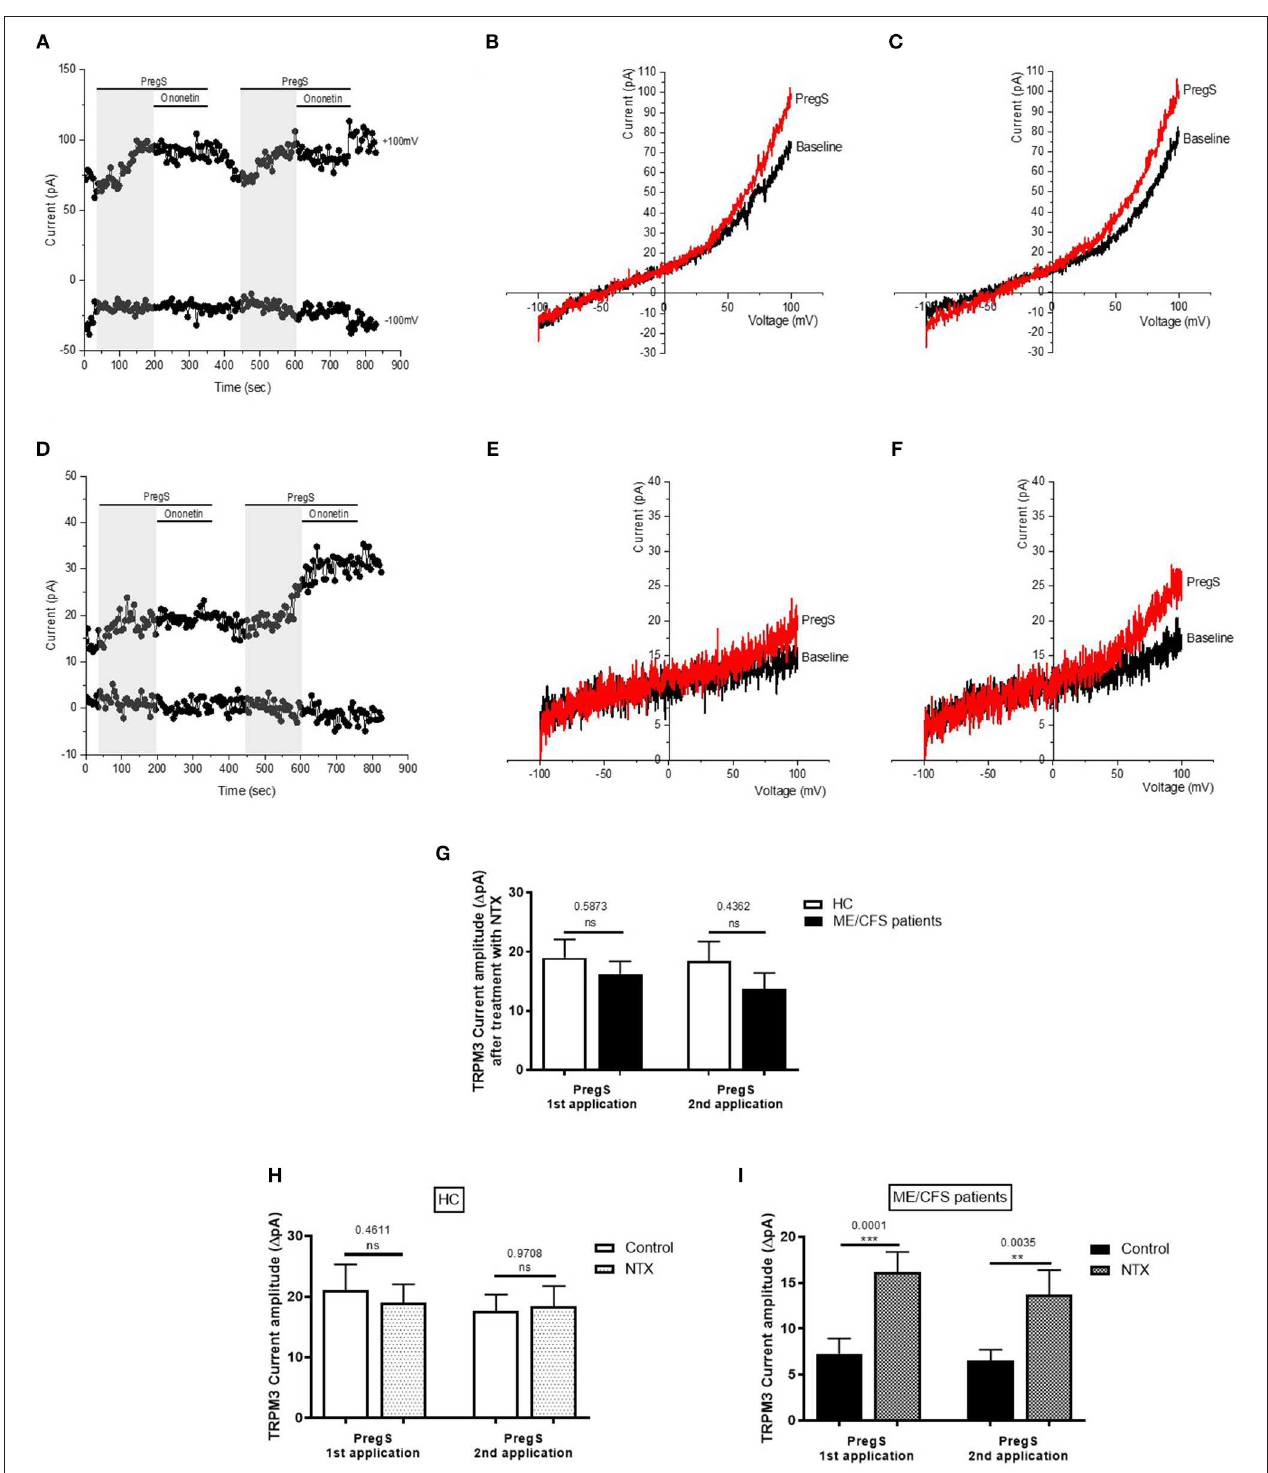
FIGURE 4 | Effects of treatment with NTX on TRPM3 activity after successive applications of PregS. Data were obtained under whole-cell patch clamp conditions. (A) A representative time-series of current amplitude at + 100mV and − 100mV showing the effect of successive applications of 100 µ M PregS (gray) on ionic currents in IL-2 stimulated NK cells treated with 200 µ M NTX for 24h from HC. (B) I – V before and after the first PregS stimulation in a cell corresponding with (A). (C) I – V before and after the second PregS stimulation in a cell corresponding with (A). (D) A representative time-series of current amplitude at + 100mV and − 100mV